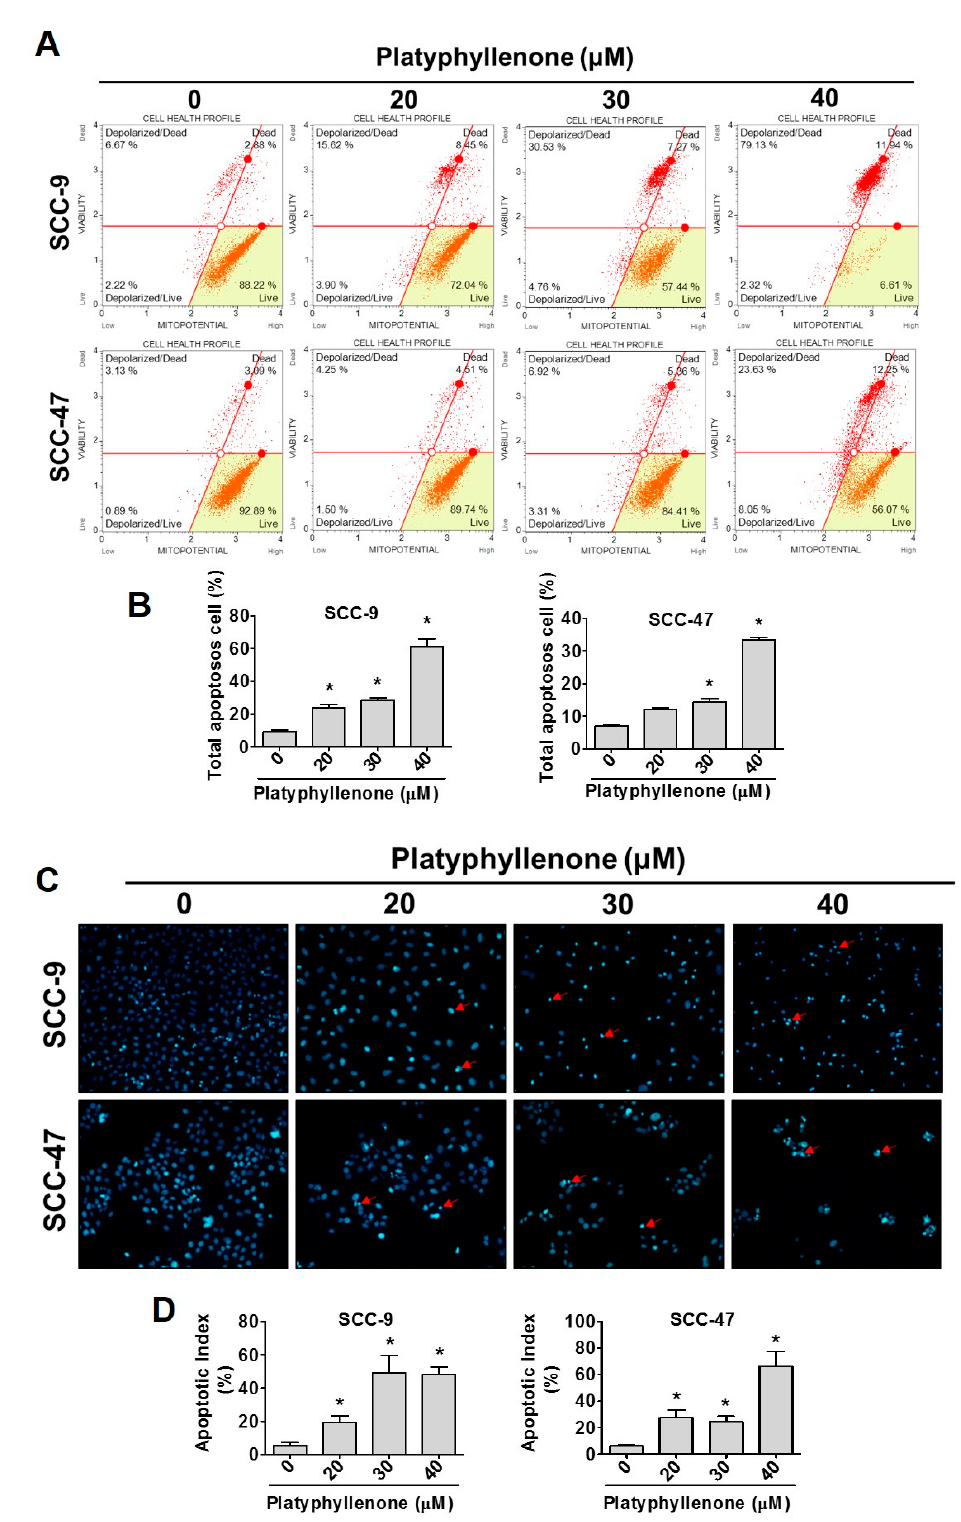
Figure 3. Platyphyllenone induces cell apoptosis in oral cancer cells. ( A , B ) SCC-9 and SCC-47 cell lines were treated with 0–40 µ M of platyphyllenone and analyzed through flow cytometry after annexin-V/PI double staining, and the results of both cells were quantified. ( C , D ) SCC-9 and SCC-47 cells were observed by DAPI staining under a fluorescence microscope, and nuclei condensation and fragmentation (red arrow) were increased with platyphyllenone concentration. The values represent the means ± SD of at least three independent experiments. Sacle bar = 100 µ m. Student’s t test was applied to determine statistical significance, and two-tailed p values are shown (* represents p <